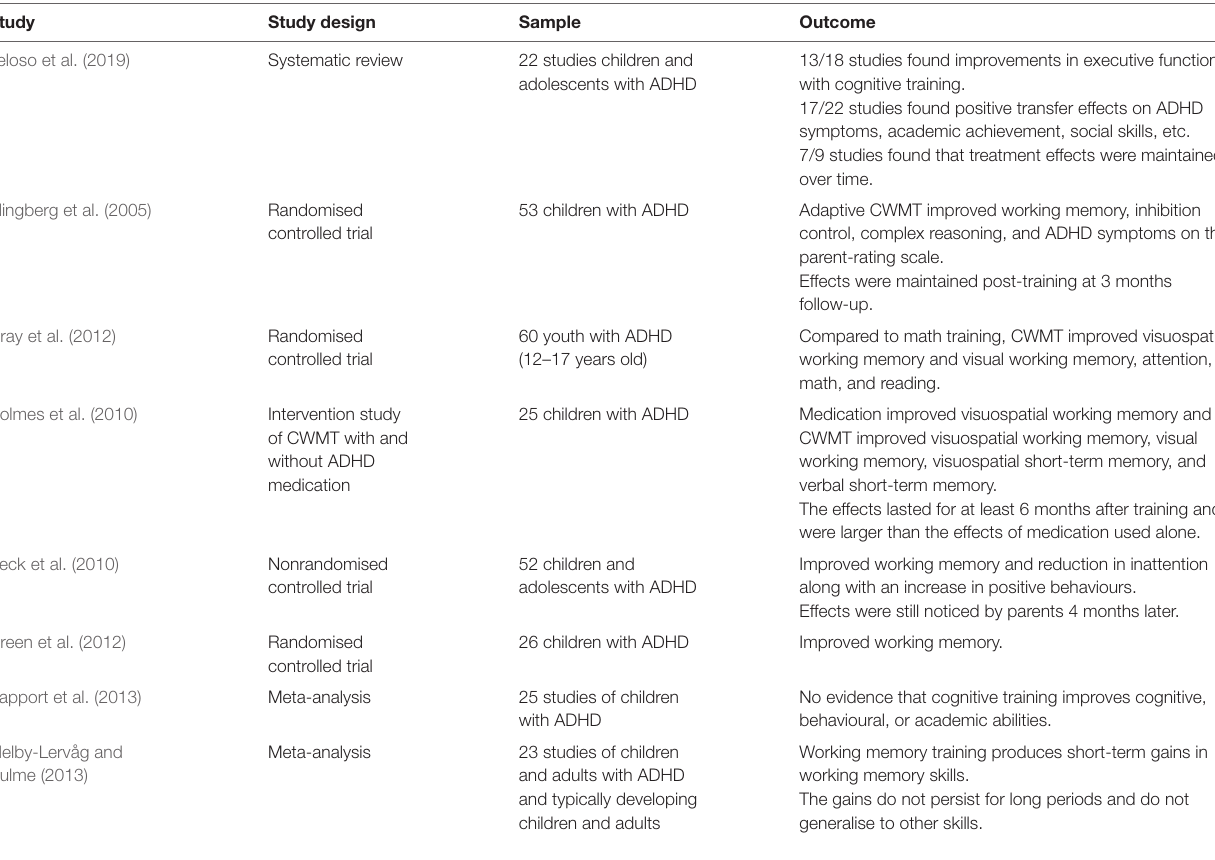
TABLE 5 | Evidence for the efficacy of Working Memory Training (WMT) in